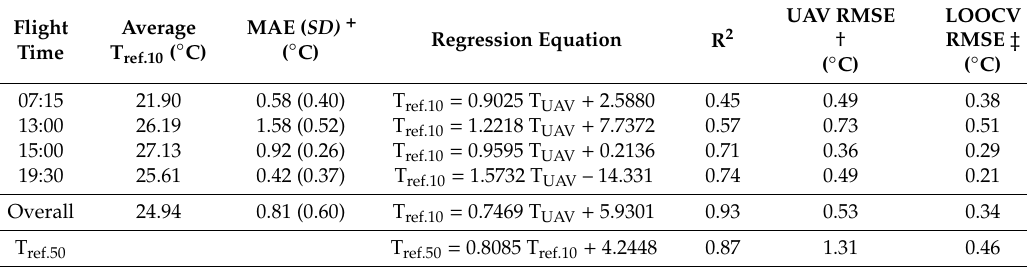
Table 2. Descriptive statistics of T ref.10 and the T UAV and the regression between the two during four UAV flights and for all flights combined. The last row shows the regression equation between T ref.10 and T ref.50 , including its R 2 and the overall UAV and LOOCV based RMSE of T ref.50